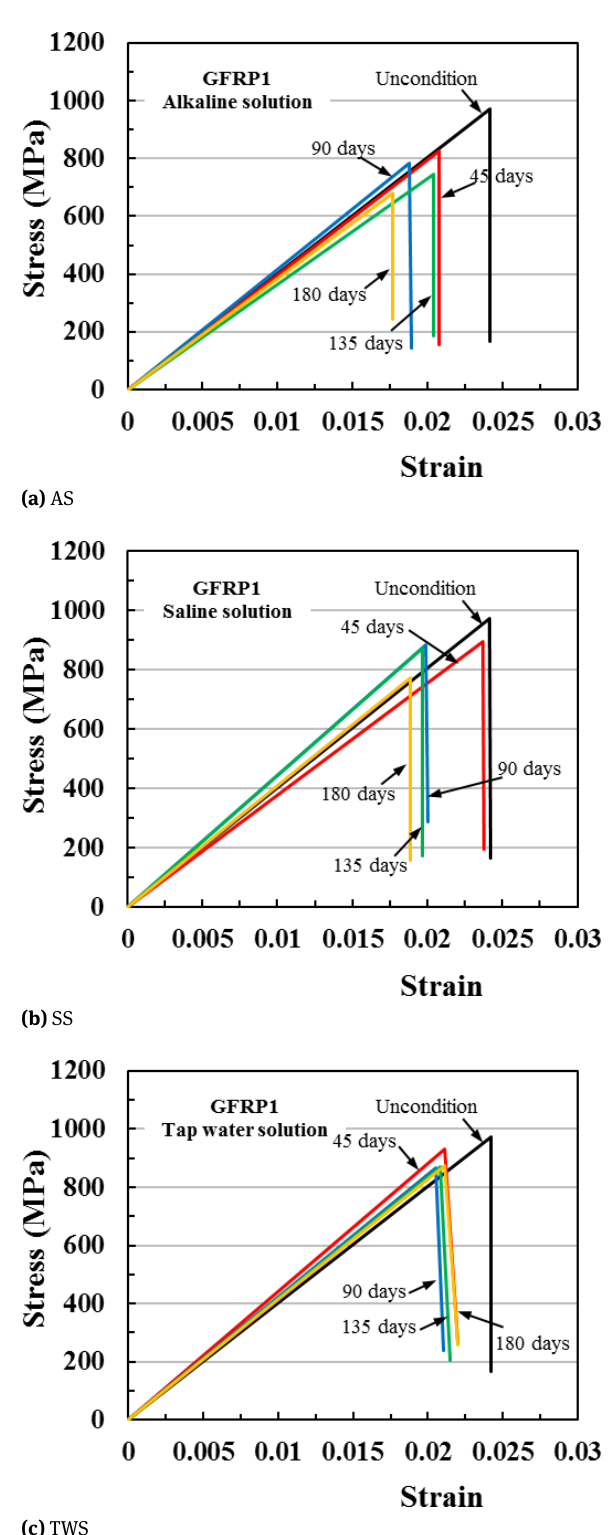
Figure 4: Experimental setups of mechanical tests